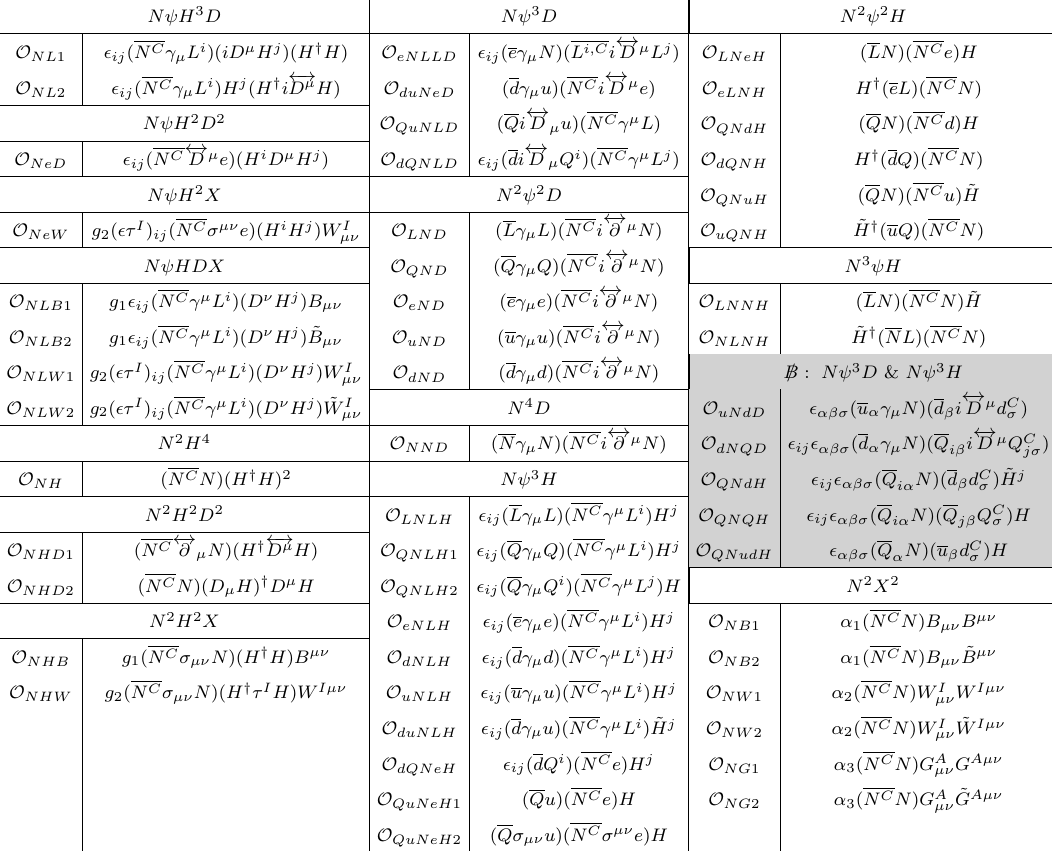
Table 9 . The basis of dim-7 operators involving RH neutrino N in SMNEFT, where all of the operators are non-hermitian with the net global quantum number j (cid:1) L (cid:0) (cid:1) B j = 2. Here g 1 ; 2 ; 3 are the gauge coupling constants for the gauge groups U(1) Y ; SU(2) L ; SU(3) C , respectively, and (cid:11) i = g 2 = (4 (cid:25) ). i